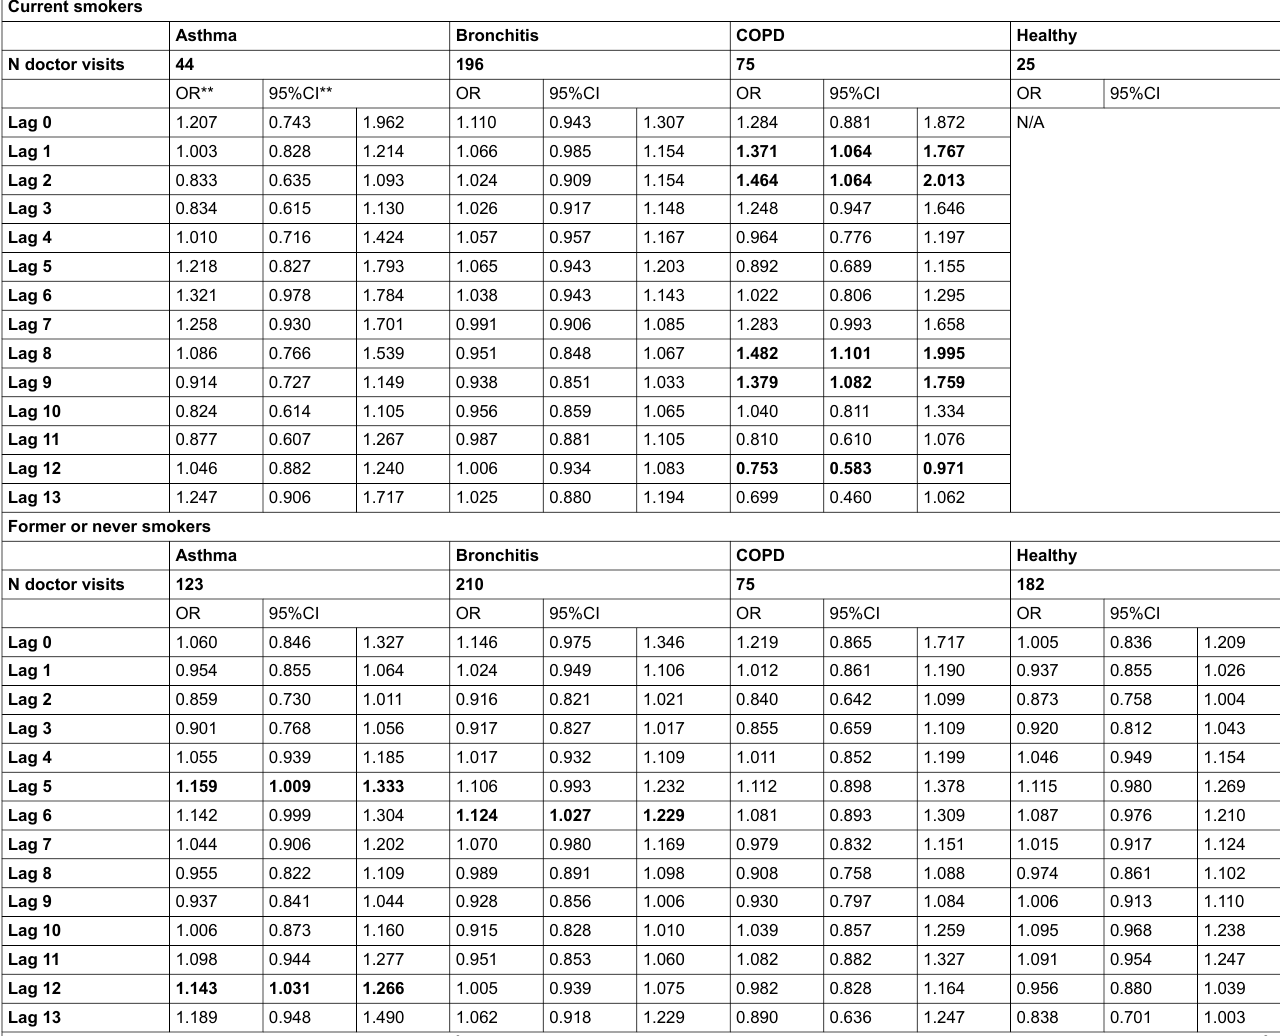
Supplementary file: Table 2 Adjusted OR's* for doctor’s visit for respiratory symptoms per 10 µg/m 3 increase in NO 2 after stratification by smoking status. Current